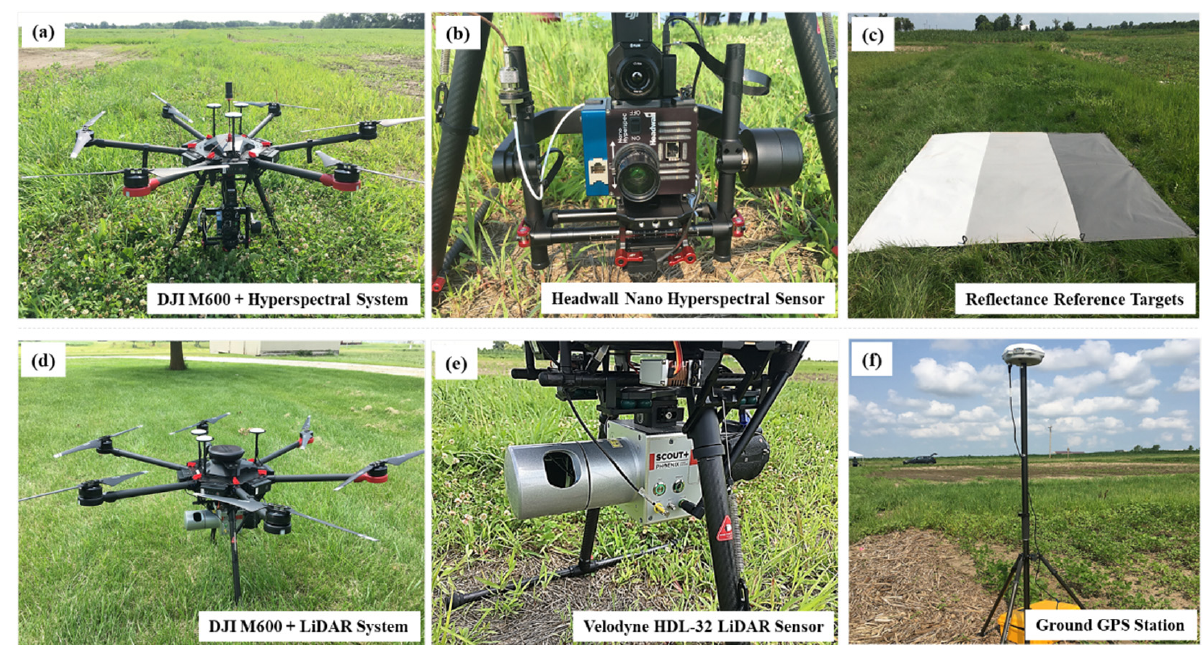
Figure 3. UAV systems and sensors used for data collection. ( a ) DJI M600 UAV platform with Hyperspectral Sensor. ( b ) Headwall Nano Hyperspectral Sensor. ( c ) Reflectance Reference Targets. ( d ) DJI M600 UAV platform with LiDAR sensor. ( e ) Velodyne HDL-32 LiDAR Sensor. ( f ) Ground RTK GPS Station.The figure was modified after [43] . Table 2. Hyperspectral and LiDAR sensors used in this study.